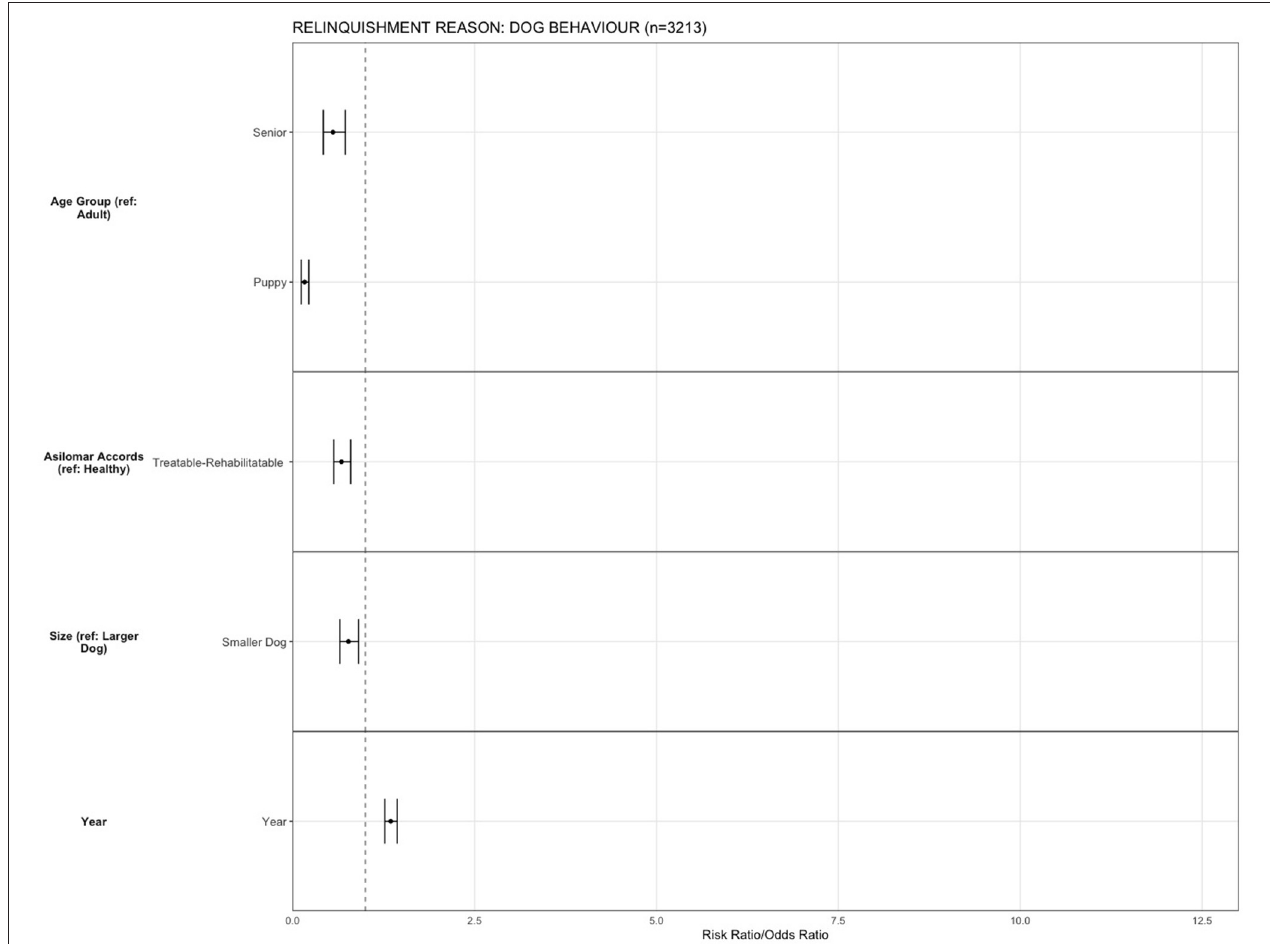
FIGURE 8 | The association between relinquishment reason and animal characteristics for puppies and dogs relinquished for the reason of “dog behavior” ( n = 3,213). Characteristics include age group, Asilomar Accords category, breed type, dog size, sex, population center size, and year. The results of the logistic regression model are shown. Data are presented by risk ratios and their 95% confidence interval (bars); p < 0.05 when 95% confidence interval does not cross the vertical dotted line. A risk ratio > 1 suggests an increased risk of relinquishment of that the characteristic category, while a risk ratio < 1 suggests a reduced risk. Non-statistically significant results are excluded from the